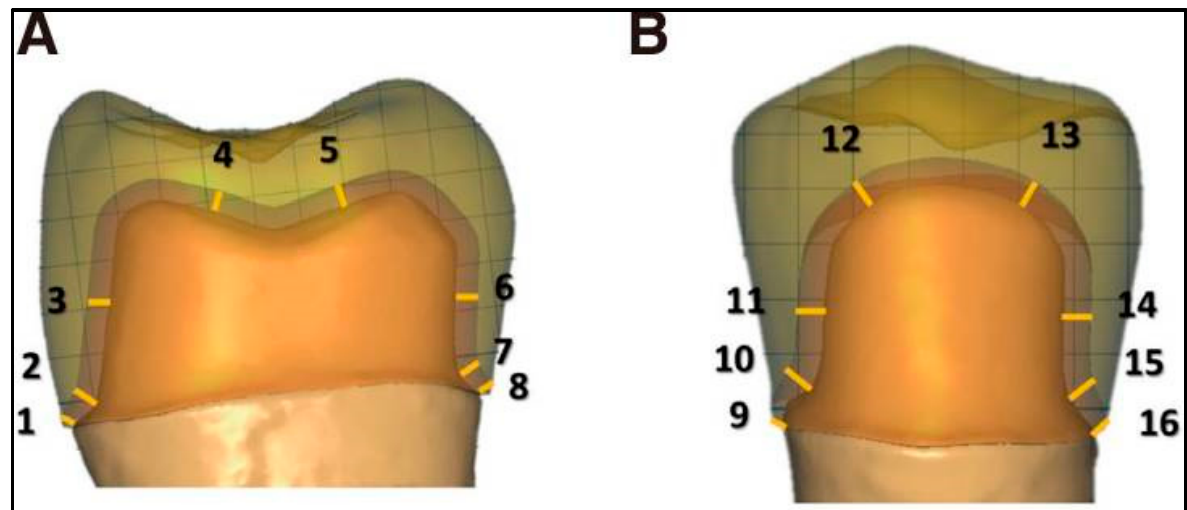
Figure 5. Sixteen measuring points for the marginal and internal gap of the crown. ( A ) Buccopalatal section, ( B ) Mesiodistal section. Marginal gap (MG): 1, 8, 9, 16; cervical gap (CG): 2, 7, 10, 15; axial gap (AG): 3, 6, 11, 14; occlusal gap (OG): 4, 5, 12, 13. The figure is adapted from ref. [95], with permission from Elsevier.